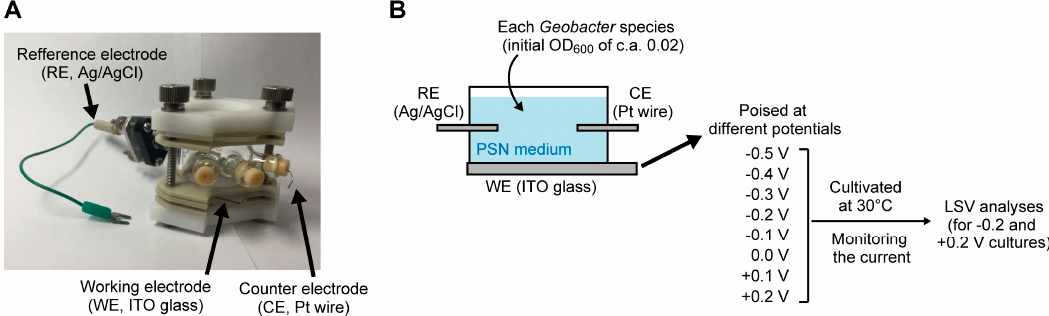
Figure 3. ( A ) The appearance of an electrochemical cell used in this study; ( B ) The experimental scheme of this study.